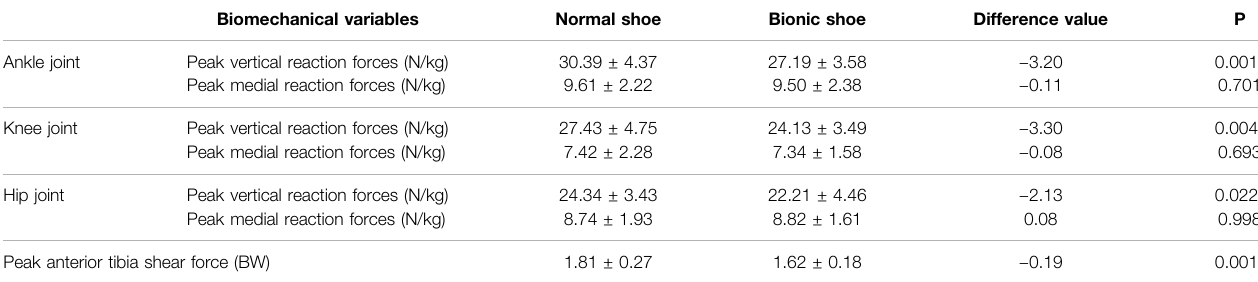
TABLE 4 | Comparison of joint vertical reaction forces, joint medial reaction forces and anterior tibia shear force (means and standard) between NS and BS during single leg landing phase. Biomechanical variables Normal shoe Bionic shoe Difference value